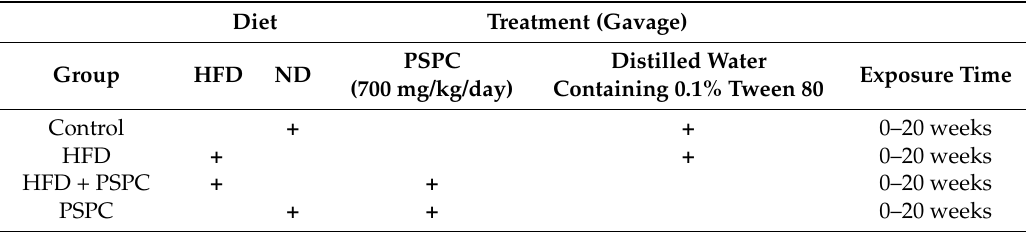
Table 1. Details of PSPC